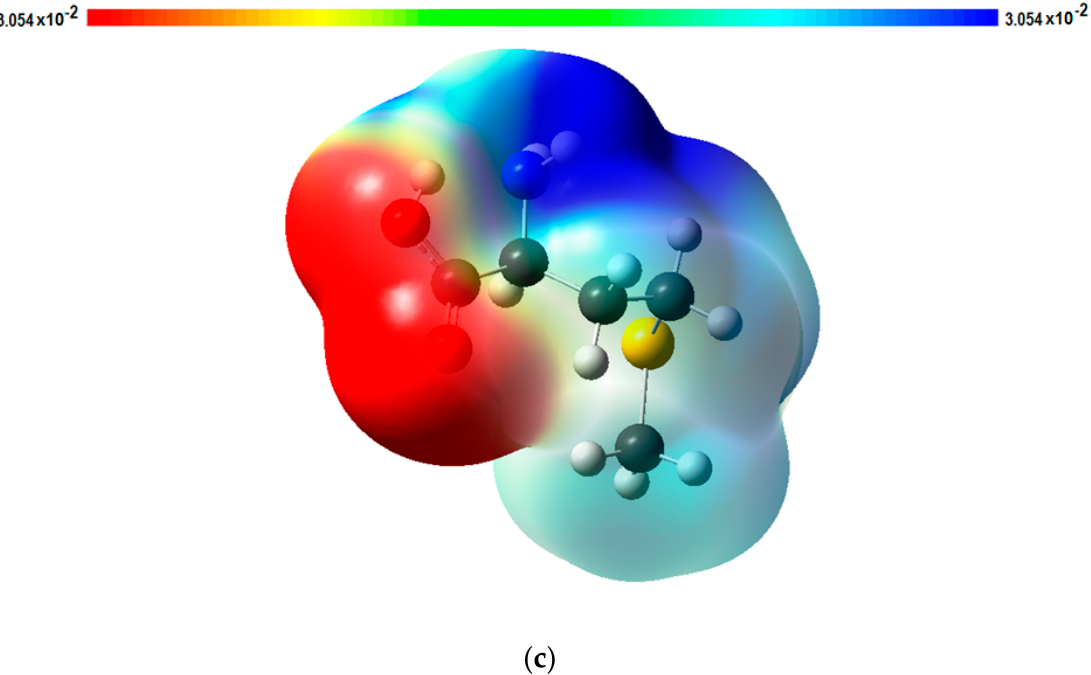
Figure 3. Effect of different scan rates: ( a ) Cyclic voltammograms of 1 × 10 − 3 M DA at different scan rates (a-k; 50, 100, 150, 200, 250, 300, 350, 400 mV ∙ s − 1 ) in 0.1 M PBS (pH 7.0); ( b ) Effect of different scan rates on the oxidation peak current of 1 × 10 − 3 M DA at the PMCPE. ( c ) An electrostatic potential map of methionine.